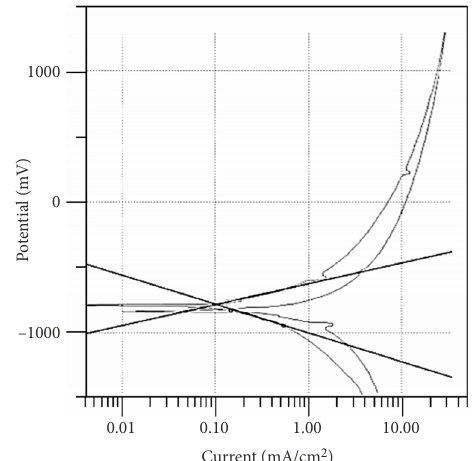
Figure 7. Cyclic polarization of composite reinforced